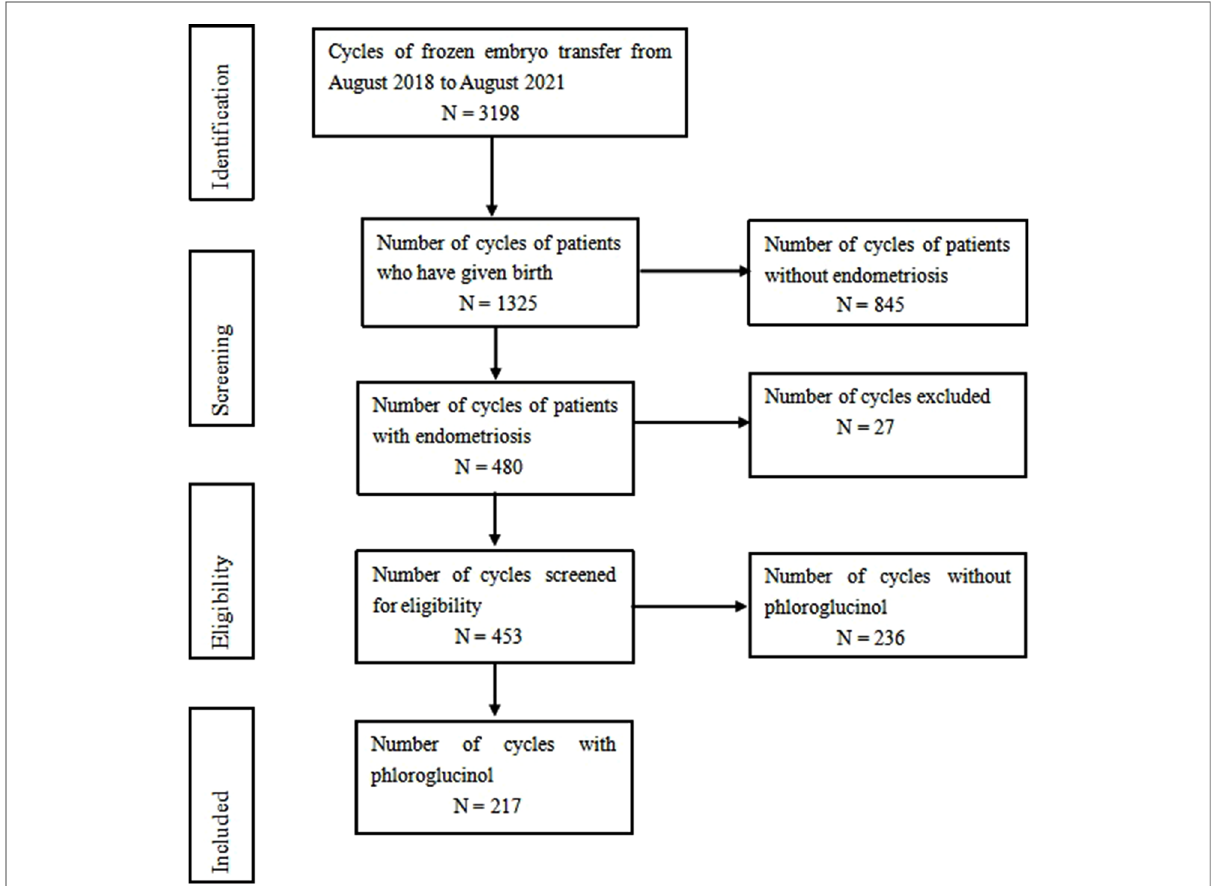
FIGURE 1 From August 2018 to August 2021, 3198 cycles of frozen embryo transfer were screened, including 1325 cases of delivery and 480 cases of endometriosis. According to the inclusion and exclusion criteria, 453 cases met the inclusion criteria, including 217 cases with phloroglucinol and 236 cases without